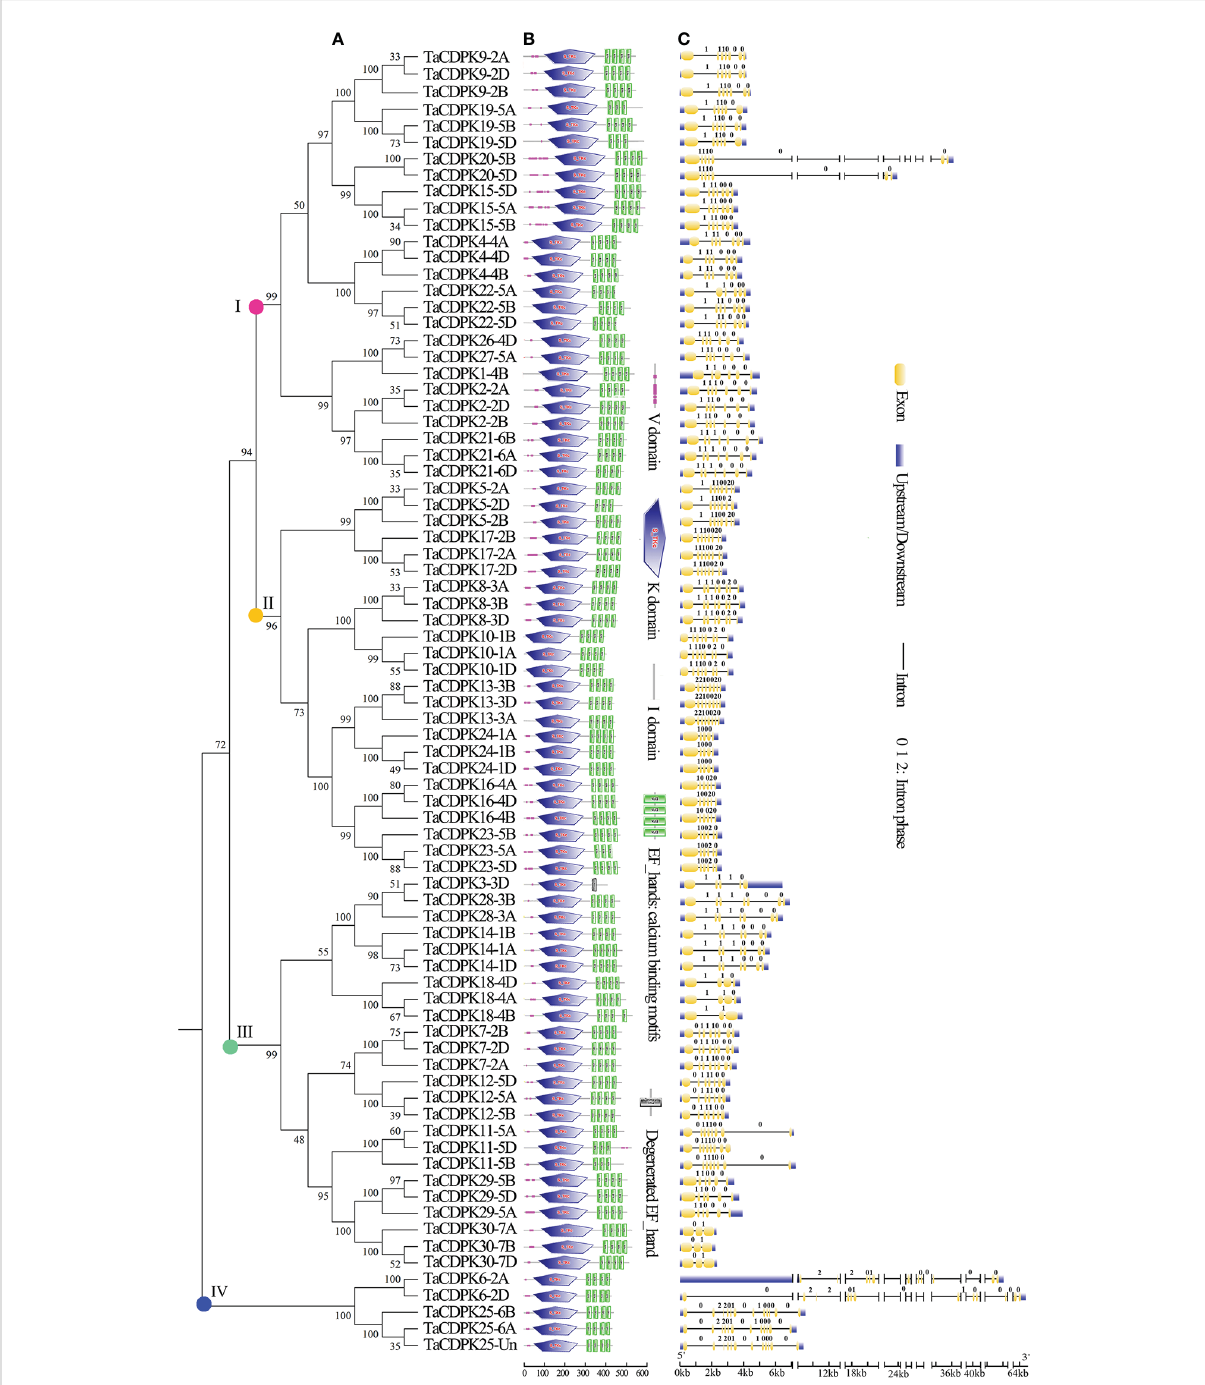
FIGURE 1 Phylogenetic relationship, domain organization, and exon/intron structure analysis of CDPK family members in wheat. (A) The unrooted maximum-likelihood phylogenetic tree of TaCDPK family members were made with MEGA 6.06. Numbers above the nodes represent bootstrap values from 1,000 replications. (B) Domain organization of the TaCDPKs. The logos of domain organization were obtained from EMBL-EBI and SMART websites and were amended with Adobe_Photoshop_CS6. The domains: V represents variable domain; K represents catalytic domain; I represents auto-inhibitory domain; C represents the region of calcium binding motifs: EF_hands. (C) The exon/intron structures of CDPK family genes in wheat. The numbers 0, 1, and 2 represent the phase of each intron in the